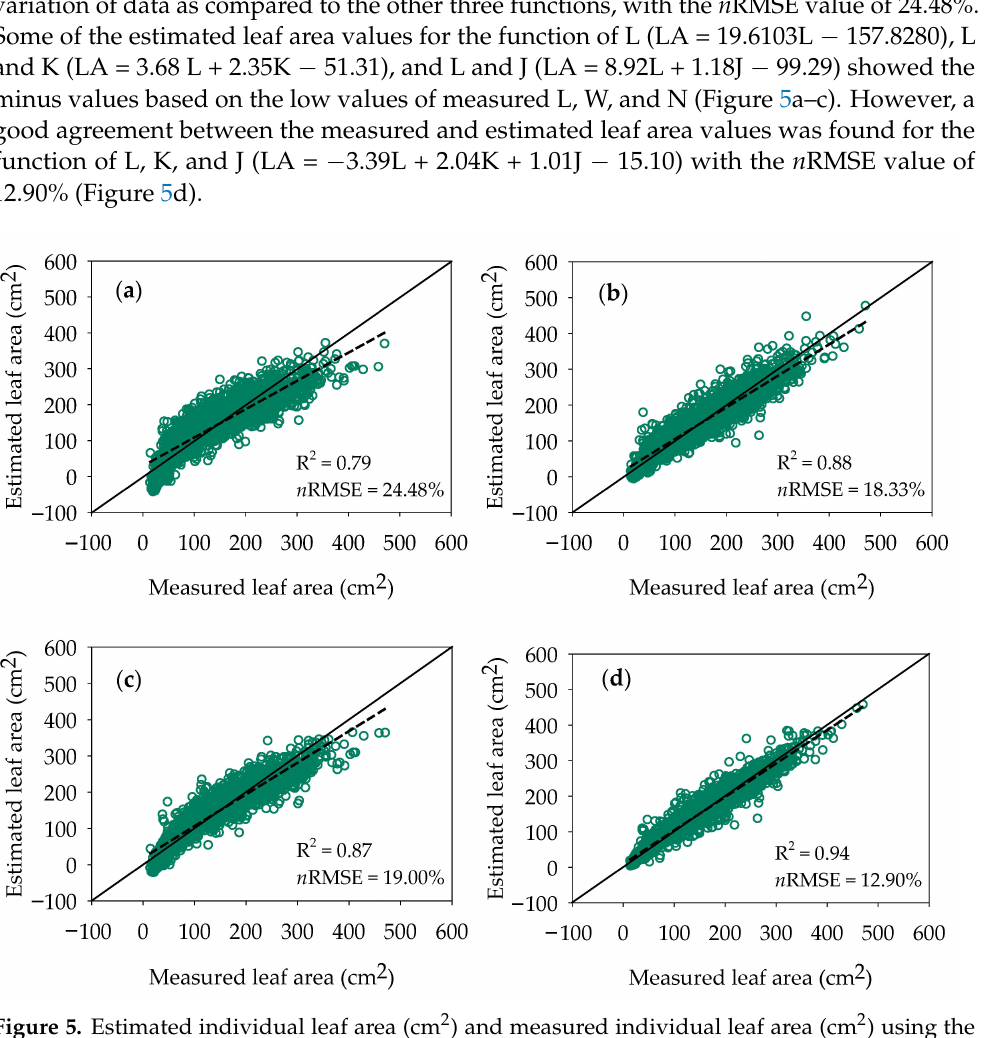
Table 2. The function models for estimating leaf area (LA) as a function of the length of the central lobe (L), the product of length and width (K), and the product of the length and number of lobes (J). Independent Variable Function R 2 L LA = 19.61L − 157.83 0.79 L, K LA = 3.68 L + 2.35K − 51.31 0.88 L, J LA = 8.92L + 1.18J − 99.29 0.87 L, K, J LA = − 3.39L + 2.04K + 1.01J − 15.10 0.94 R 2 = coefficient of determination.